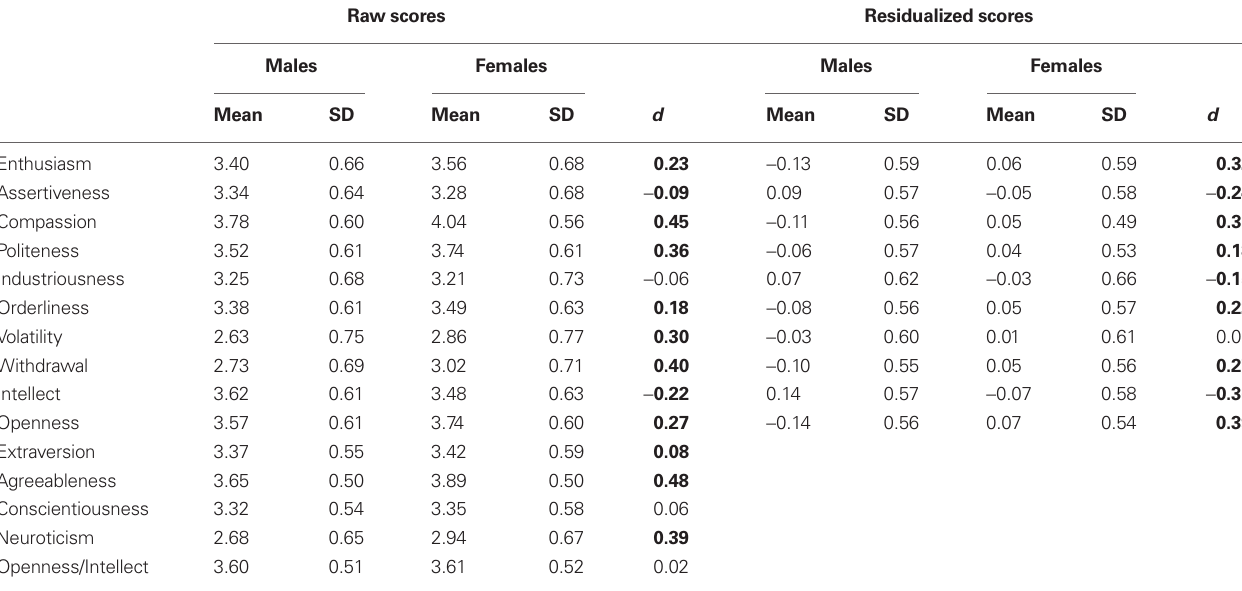
Table 2 | Mean and SD for Big Five domains and raw and residualized aspect scores.